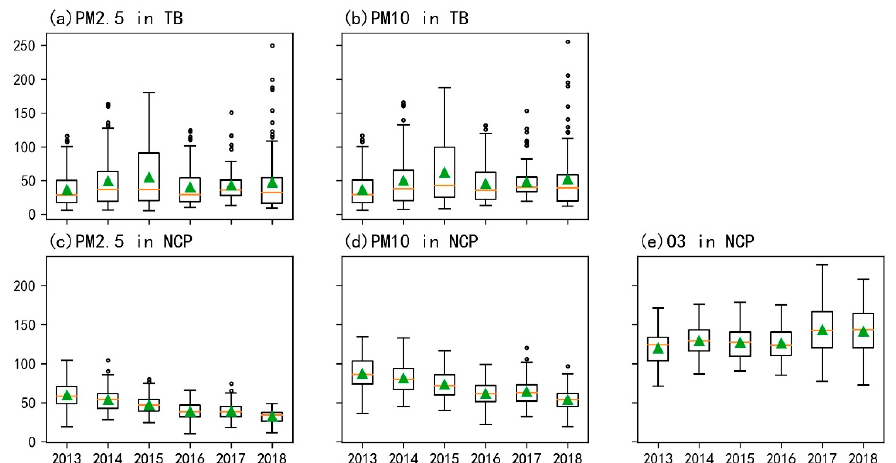
Figure 4. Interannual variation in the average pollutant concentrations in the Tarim Basin ( a , b ) and the North China Plain ( c – e ) (unit: μ g·m − 3 , orange lines represent the median, green triangles represent the average value, and hollow dots represent the discrete value).